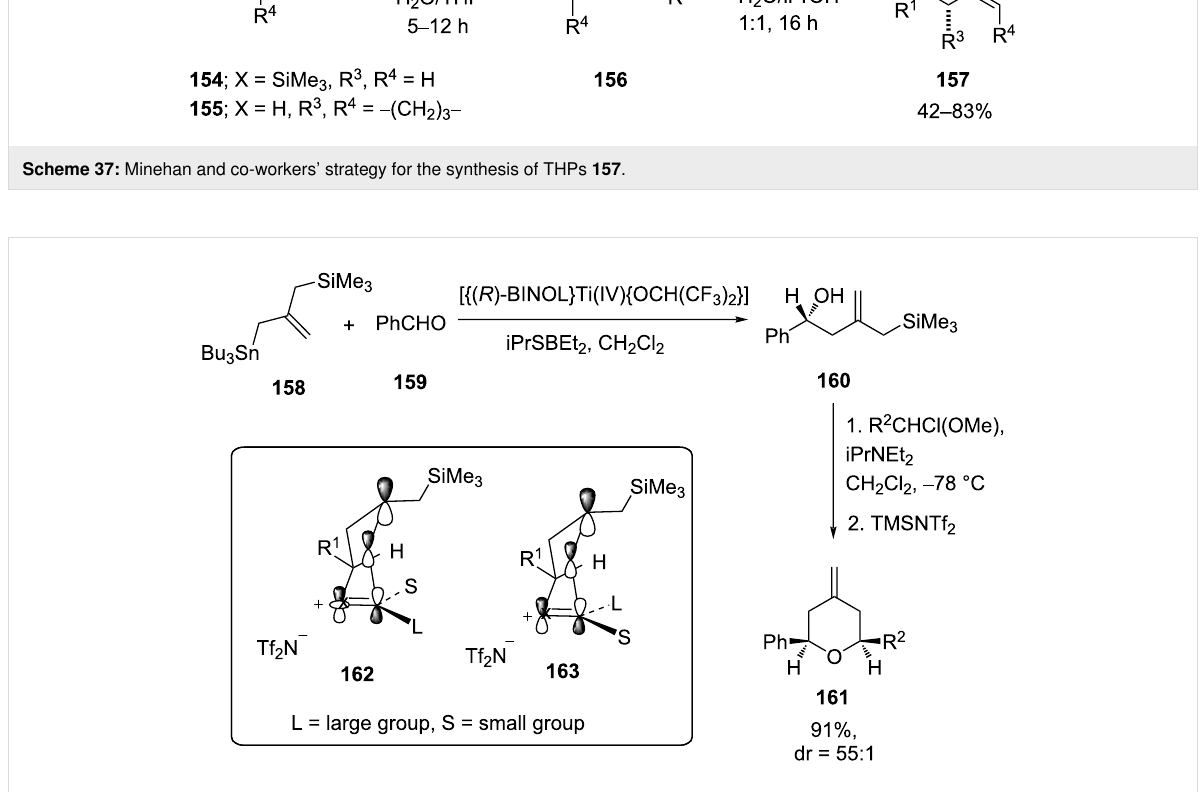
Scheme 38: Yu and co-workers’ allylic transfer strategy for the construction of tetrahydropyran 161